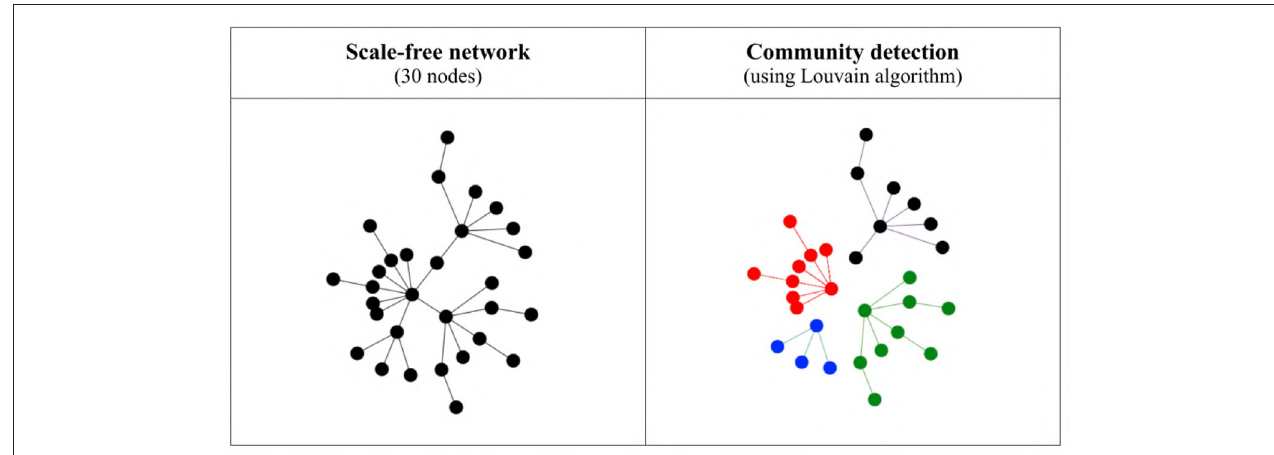
FIGURE 4 | Structural communities detected in a very simple scale-free network using the Louvain algorithm. On the left is the original network with all connections, and on the right the four communities detected by the algorithm (shown in different colors and with the inter-community connections removed).